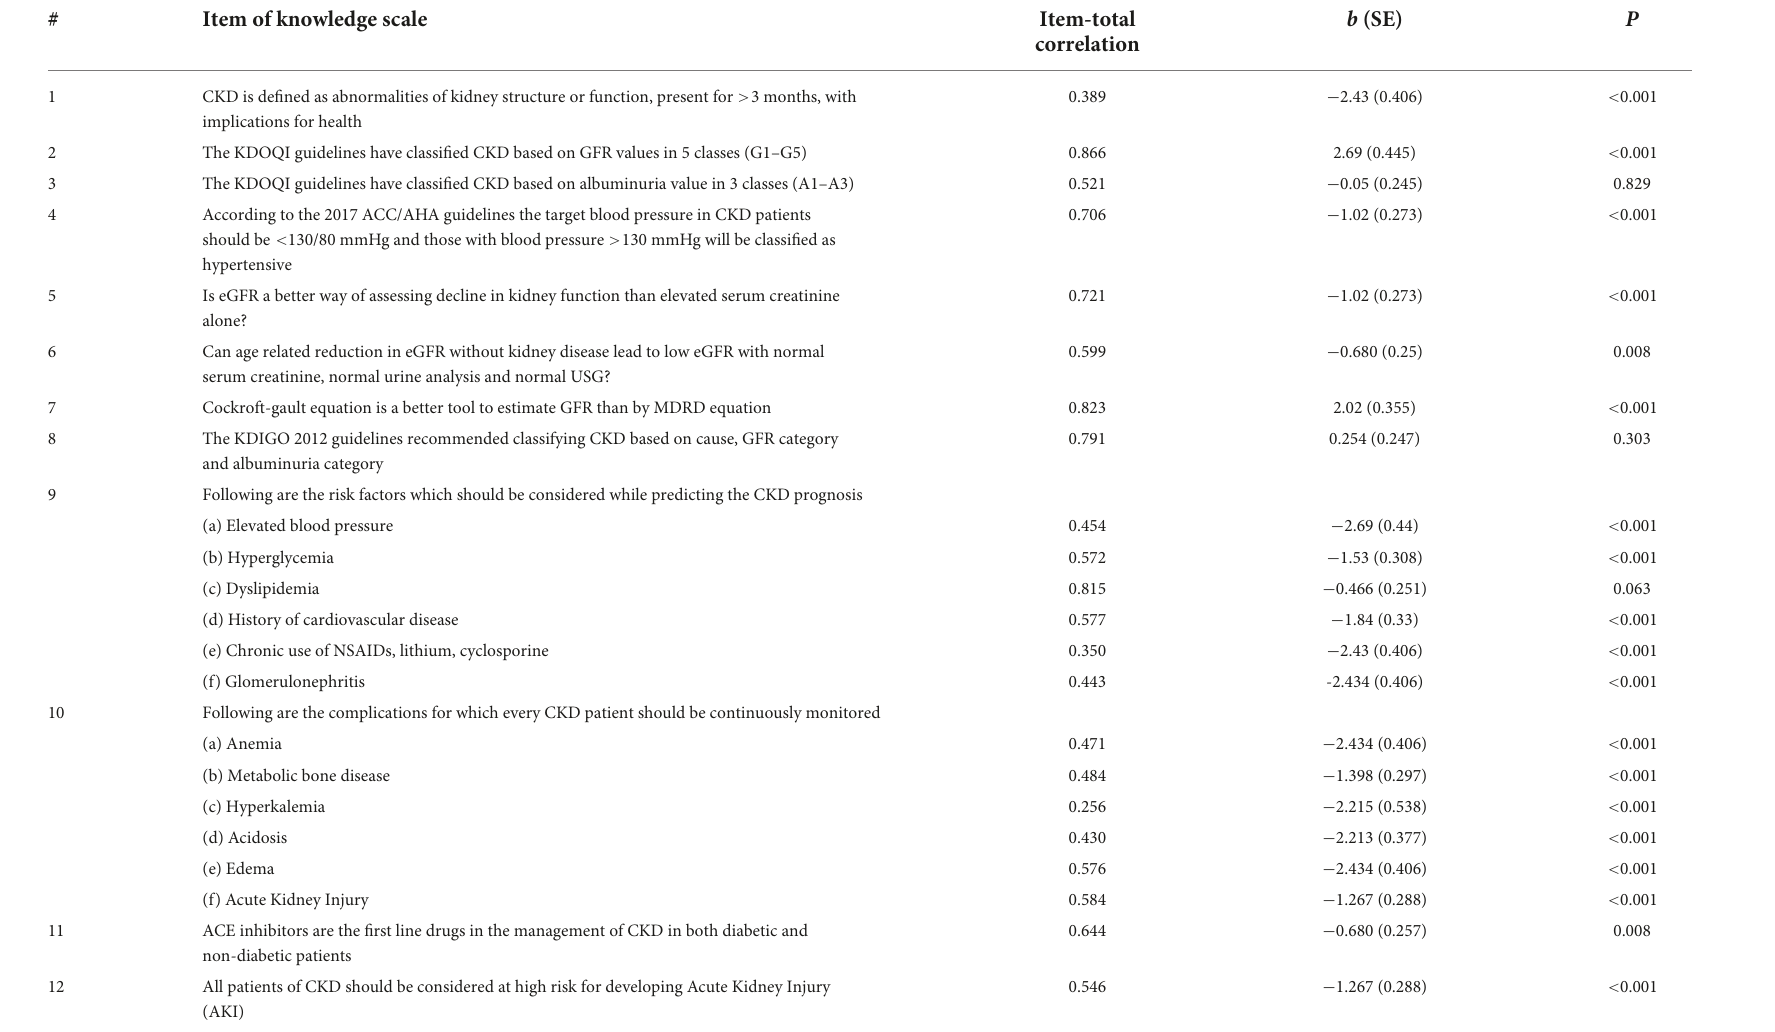
TABLE 2 Results of the IRT analysis in the knowledge section of the validation